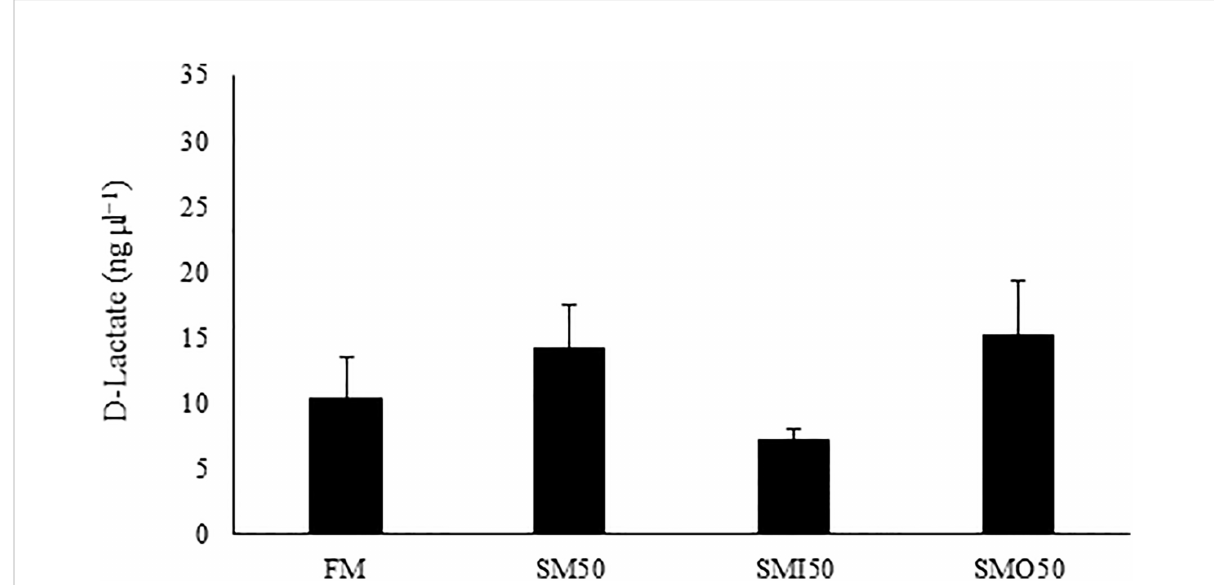
FIGURE 1 Serum D-lactate concentration (ng µl − 1 ) in pikeperch fed the experimental diets for 8 weeks. FM (45% crude protein and 12% crude lipid); SM50, by replacing 50% of FM with SM, SMI50, by replacing 50% of FM with SM and inulin addition; SMO50, by replacing 50% of FM with SM and oligofructose addition. The lack of superscript letter indicates no signi fi cant differences (P > 0.05) among